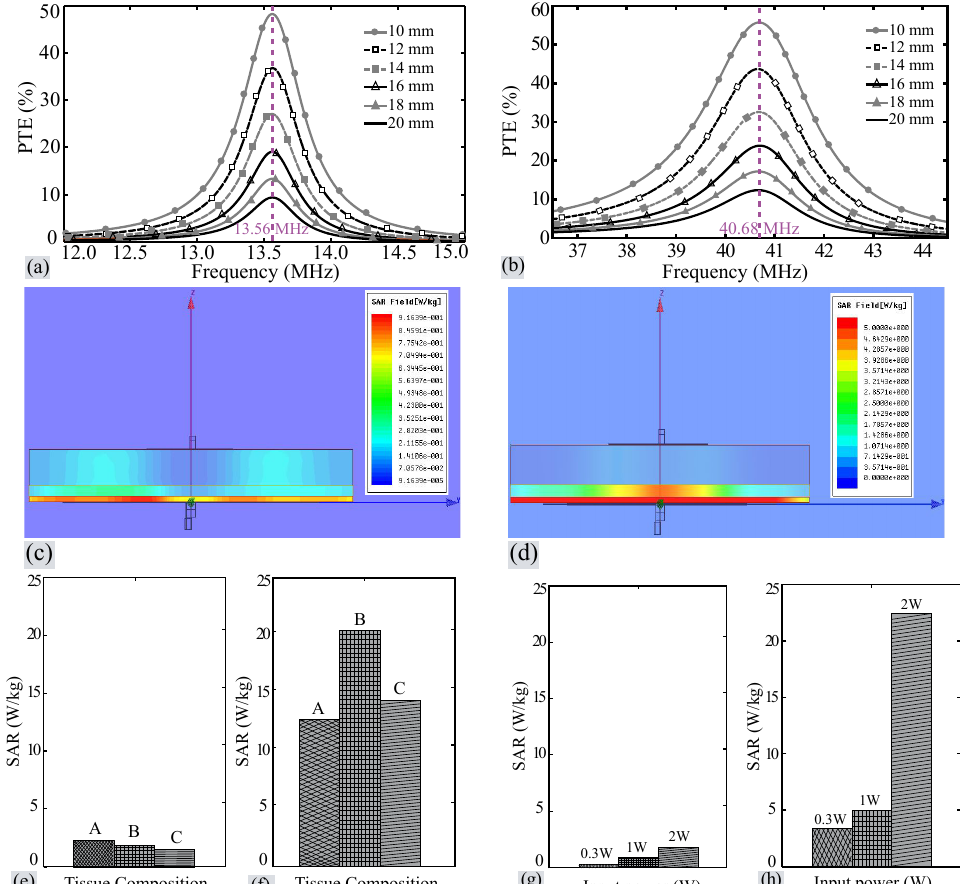
Figure 7. ( a ) PTE vs. frequency for varied distances at 13.56 MHz; ( b ) PTE vs. frequency for varied distances at 40.68 MHz; ( c ) Simulated SAR at 13.56 MHz; ( d ) Simulated SAR at 40.68 MHz ( e ) SAR vs. Tissue Composition at 13.56 MHz. ( f ) SAR vs. Tissue Composition at 40.68 MHz ( g ) SAR vs. Input power at 13.56 MHz. ( h ) SAR vs. Input power at 40.68MHz (A: 1 mm skin, 2 mm fat and 7 mm muscle, B: 1.5 mm skin, 2.5 mm fat and 6 mm muscle, and C: 2 mm skin, 3 mm fat and 5 mm